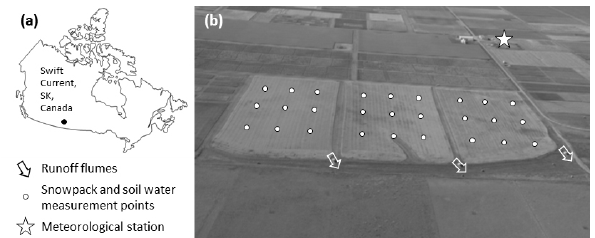
Figure 1. (a) Location of the Swift Current hillslopes in Canada. (b) Aerial photograph (facing south) of the Swift Current hillslopes (from right to left: Hillslope 1, Hillslope 2, Hillslope 3), taken in a year when wheat was grown. The runoff flumes, measurement lo- cations for snowpack and soil moisture, and the meteorological sta- tion are indicated. Figure modified, with permission, from Cessna et al. (2013) and Coles et al.